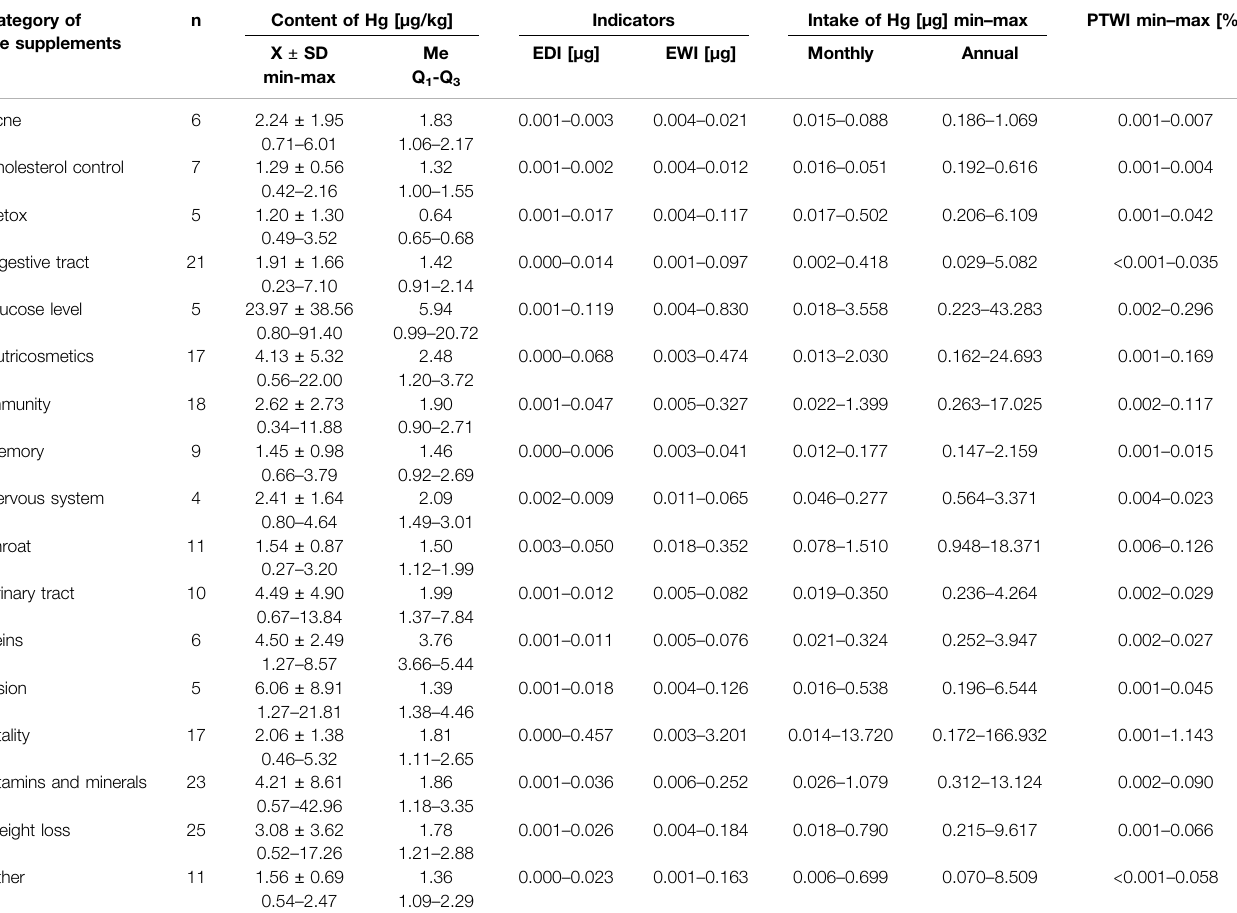
TABLE 1 | Hg content in DS and health risks of their